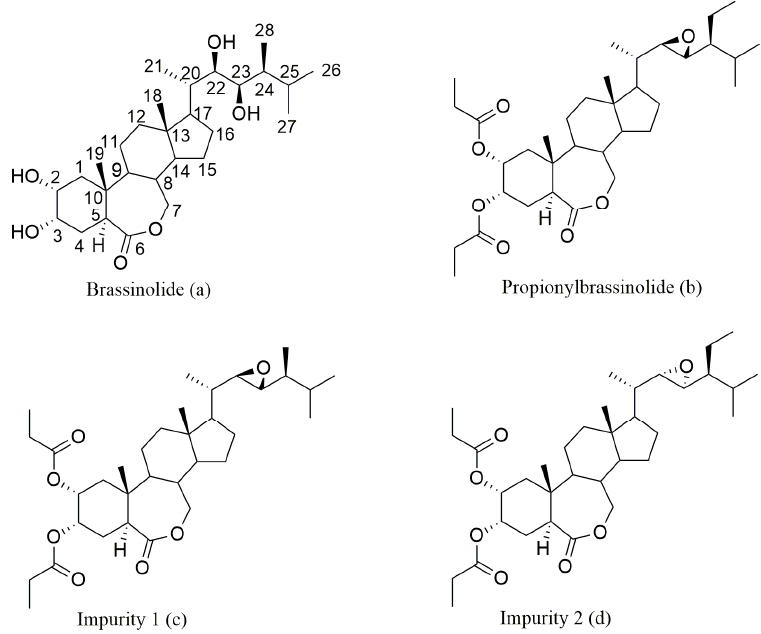
Figure 1. Chemical structures of the brassinolide, propionylbrassinolide and its impurities.